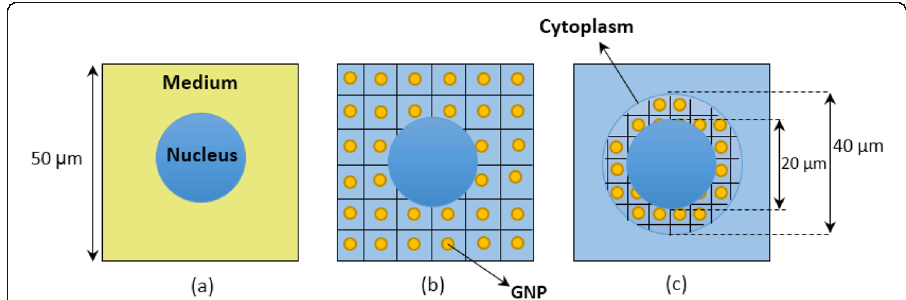
Fig. 1. A schematic cross-sectional view of the models considered for distribution of GNPs in the cell. a Gold-tissue mixture. b Homogeneously distributed GNPs in the medium. c Heterogeneous model, with GNPs distributed inside the cytoplasm surrounding the nucleus. In the mixture model, the medium is filled with a homogeneous mixture of eye melanoma and gold. In all three models, the medium is a cubic box of 50 × 50 × 50 μ m 3 , and the nucleus is filled with